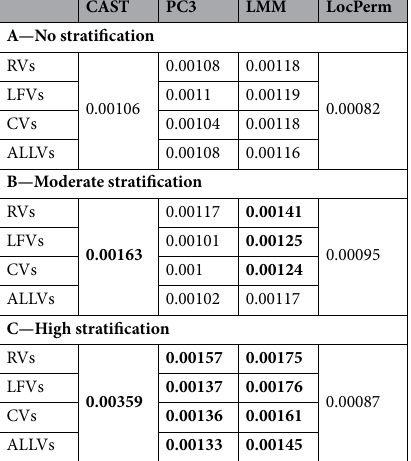
Table 1. Type I error rates of the different approaches for the large European sample. The nominal level alpha considered is α = 0.001 and the corresponding 95%PI adjusted for the 10 methods is [0.00079–0.00121]. Type I error rates under the lower bound of the 95%PI are displayed in italic and above the upper bound of the 95%PI in